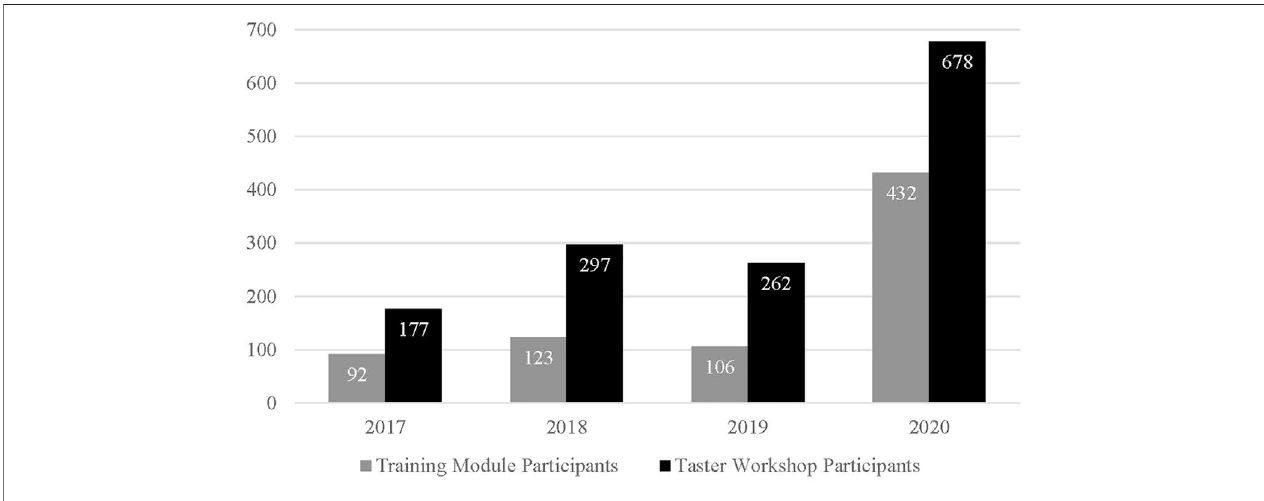
FIGURE 3 | Program participants over time, by program